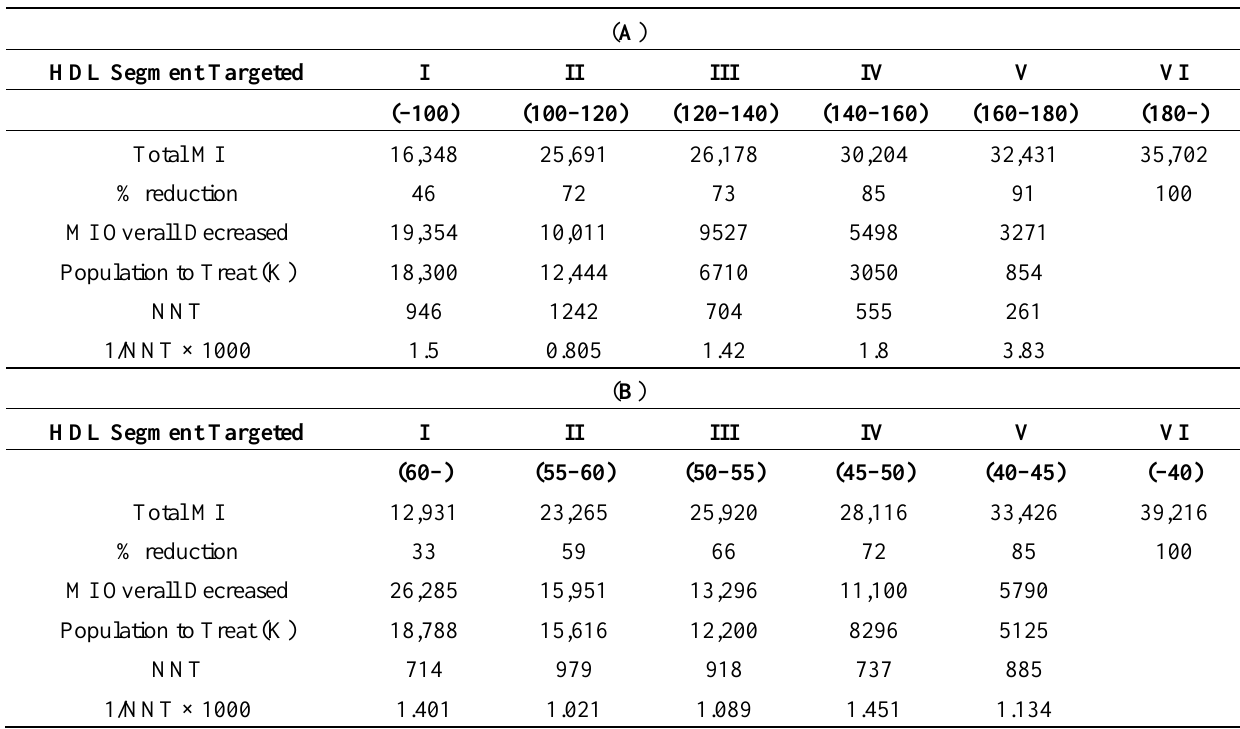
Table 3. ( A ) Number needed to treat (NNT) in prevention of myocardial infarction (MI) by increasing LDL cholesterol (male); ( B ) NNT in prevention of MI by increasing HDL cholesterol (male).